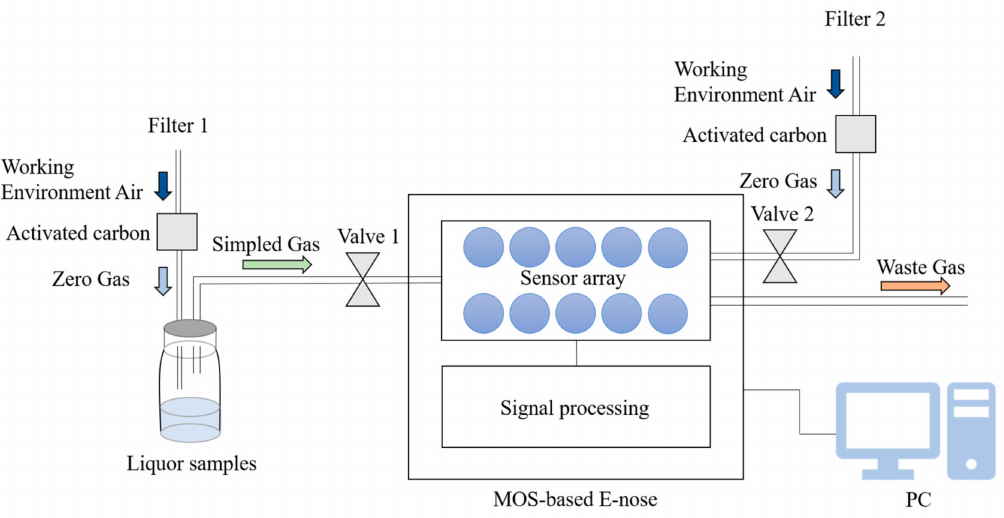
Figure 1. Schematic diagram of the PEN-3